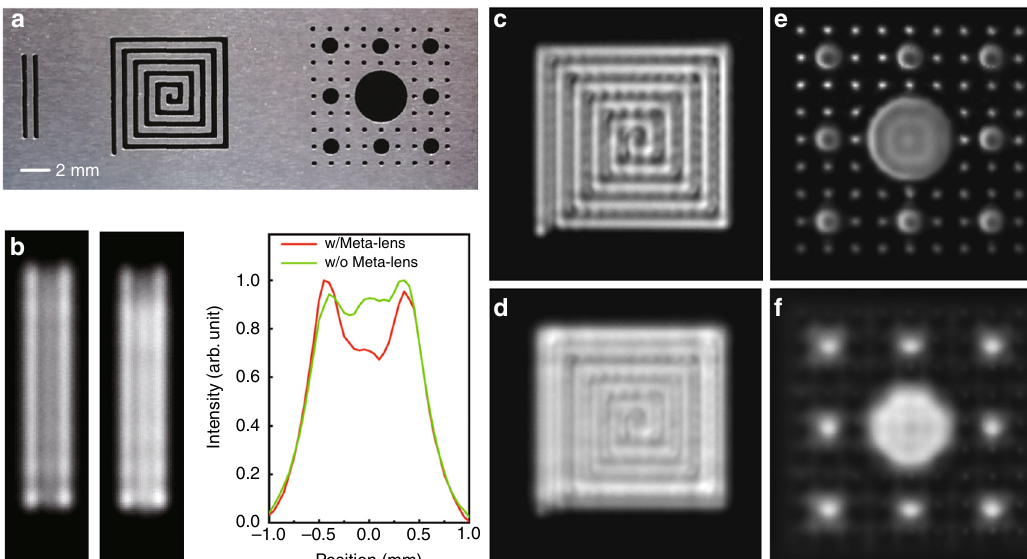
Fig. 5 Super-resolution ultrasound imaging. a The photograph of the mask sheet carved with speci fi c patterns. b The ultrasound image of double slits. Left: super-resolution imaging via a meta-lens. Middle: conventional imaging via a periodic-belt Fresnel zone plate. Right: comparison of the intensity pro fi les across the center of double slits. The slit width and the spacing between double slits are both 0.4 mm. c Super-resolution image of a coiled slit by using the meta-lens. d Conventional image of the coiled slit by using the periodic-belt Fresnel zone plate. e Super-resolution image of a hole array by using the meta- lens. f Conventional image of the hole array by using the periodic-belt Fresnel zone